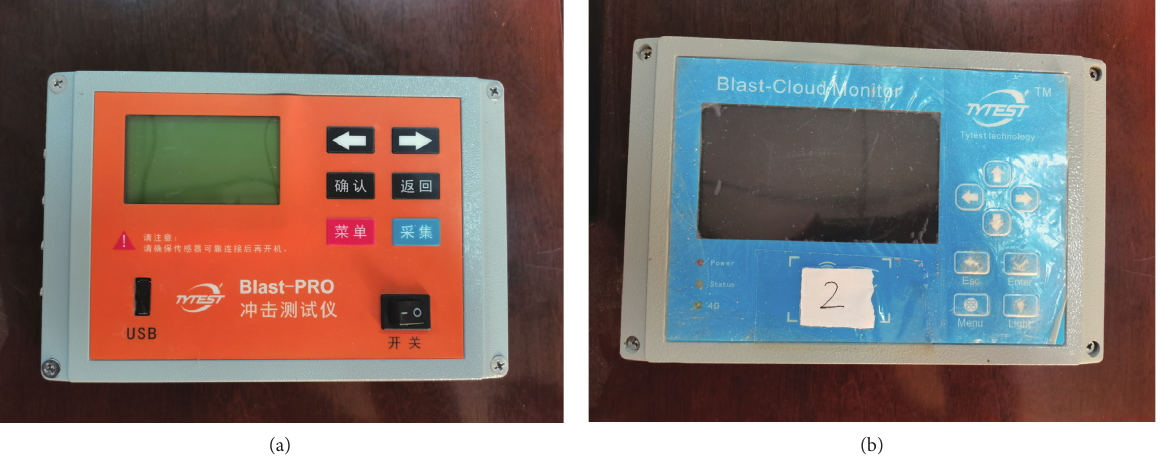
Figure 2: Equipment. (a) Blast-PRO. (b) Blast-Cloud